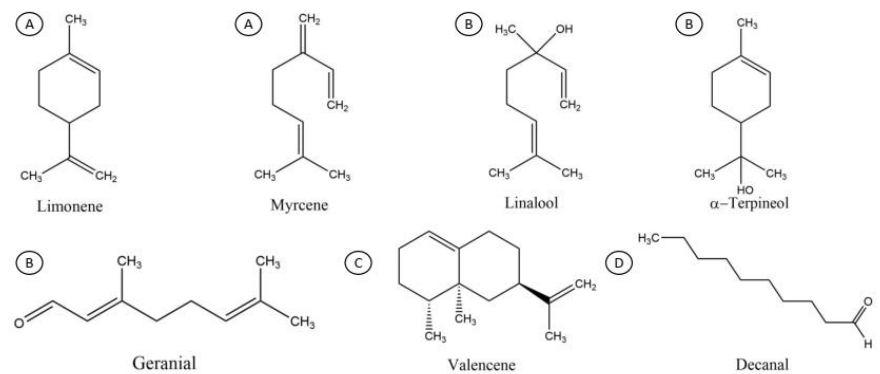
Figure 1. Chemical structures of representative major compounds for the orange essential oil and its concentrated oils, ordered as: ( A ) hydrocarbon monoterpenes; ( B ) oxygenated monoterpenes; ( C ) hydrocarbon sesquiterpenes; ( D ) oxygenated compounds.